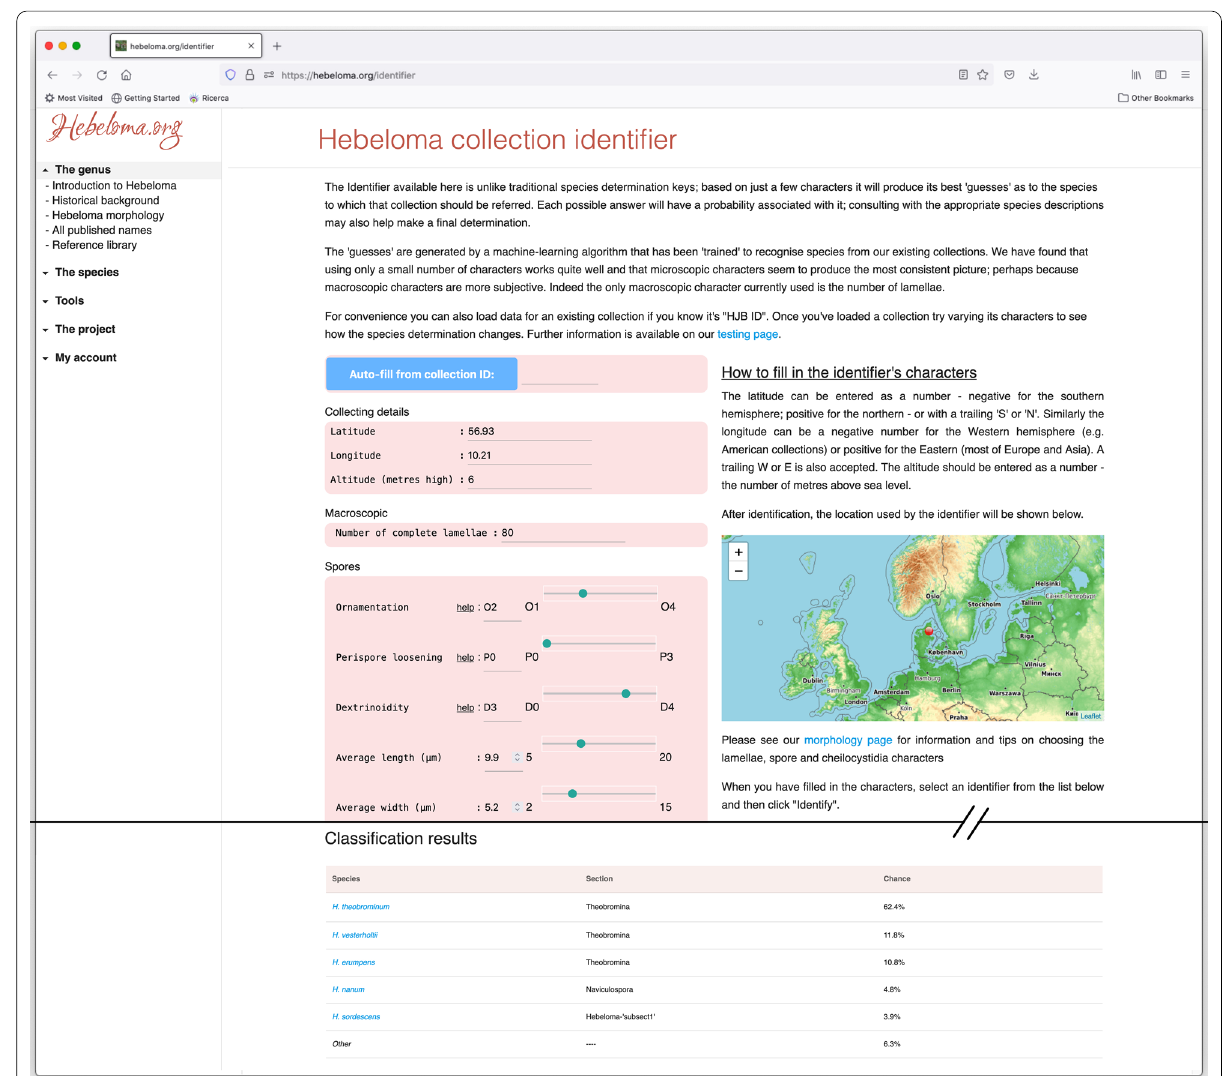
Fig. 3 Example of the species identifier on https:// hebel oma. org/ ident ifier. The upper portion of the figure shows a screenshot of the inputs that the user is asked to make. The lower portion shows the species predictions output by the machine-learning based